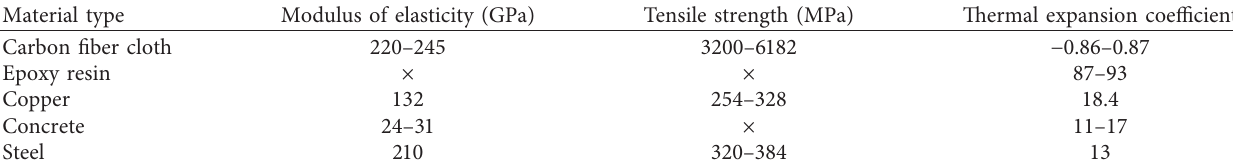
Table 1: List of different material properties.